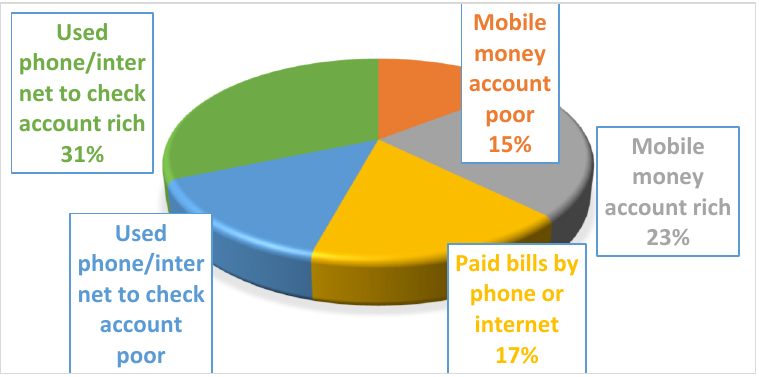
Figure 3. Use of digital finance Source of data: (Demirguc ‐ Kunt et al. 2018).